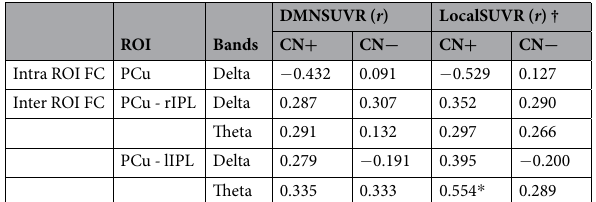
Table 3. Correlation between PiB-SUVR values and FC within each group. * p < 0.05. † LocalSUVR: standardized uptake value ratio (SUVR) values for more local ROIs were used for the correlation analysis. For intra ROI FC at PCu, SUVR values in the PCu ROI were used. For inter-ROI FC, SUVR values in the rIPLand lIPL were used for the PCu-rIPL and PCu-lIPL connections, respectively.